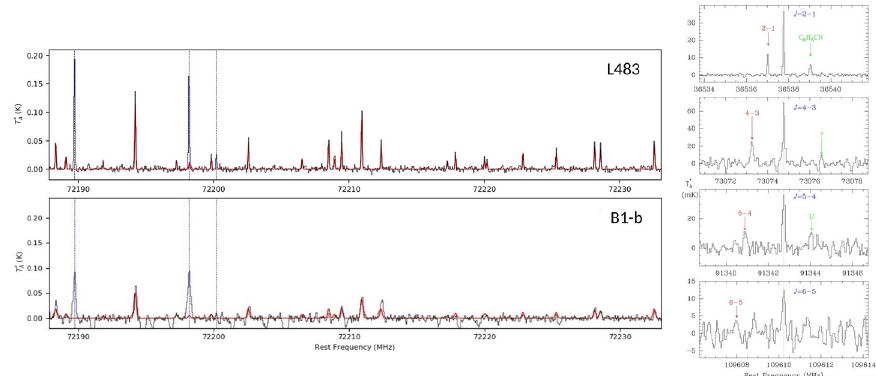
Figure 2. (left): Series of unidentified lines observed towards L483 (top panel) and B1-b (bottom panel), later assigned to the 1 0 , 1 − 0 0 , 0 transition of H 2 NC. Lines in blue correspond to hyperfine com- ponents of the N = 1 − 0 transition of CCD. (right): Observed lines of CH 3 CO + towards TMC-1. The blue labels correspond to the series of lines we assign to the A species of CH 3 CO + , while the red ones correspond to those of the E